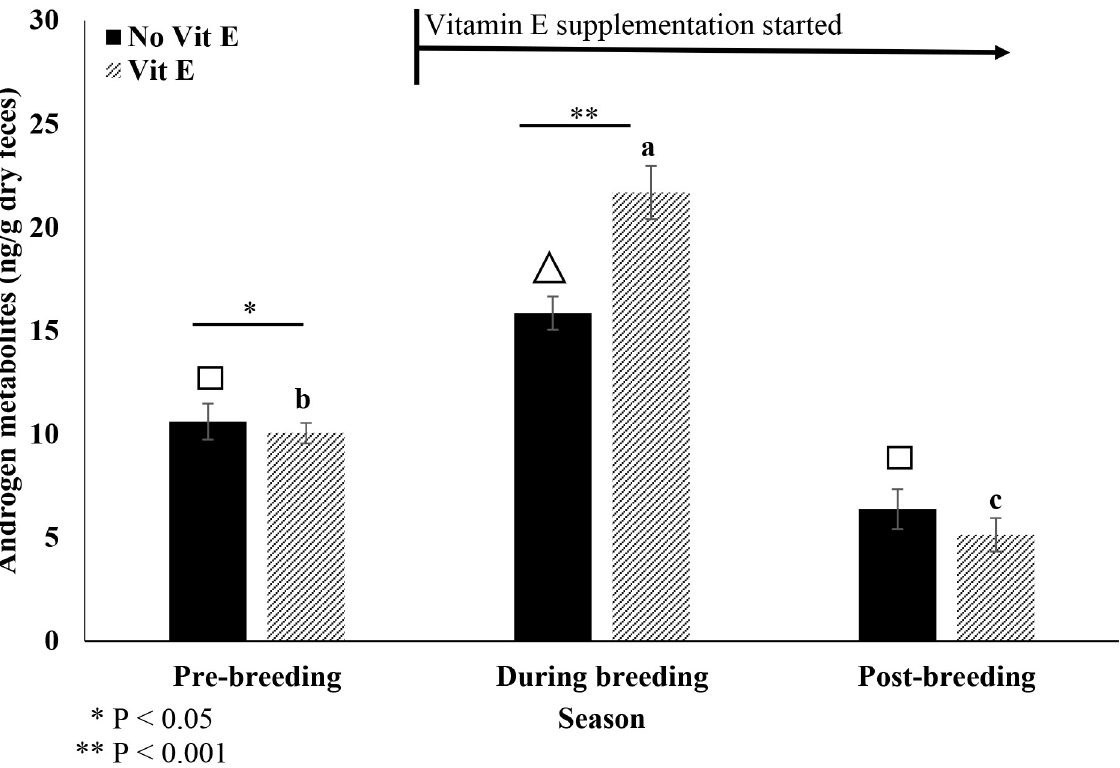
Fig 2. Mean ( ± SEM) fecal androgen metabolites (FAM) across season (pre-, during and post-breeding season) and treatment (vitamin E vs. no vitamin E). Different superscripts (a, b, c) depict differences (P < 0.05) across time in ferrets supplemented with vitamin E. Different symbols (square, triangle) depict differences (P < 0.01) across time in non-supplemented ferrets. Finally, asterisks indicate differences (P < 0.05) between treatments within each time period.